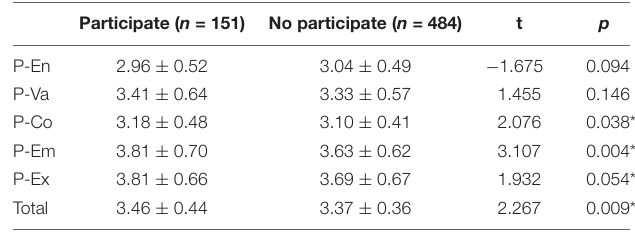
TABLE 3 | Influence of only children or not status on medical students’ professional identity.